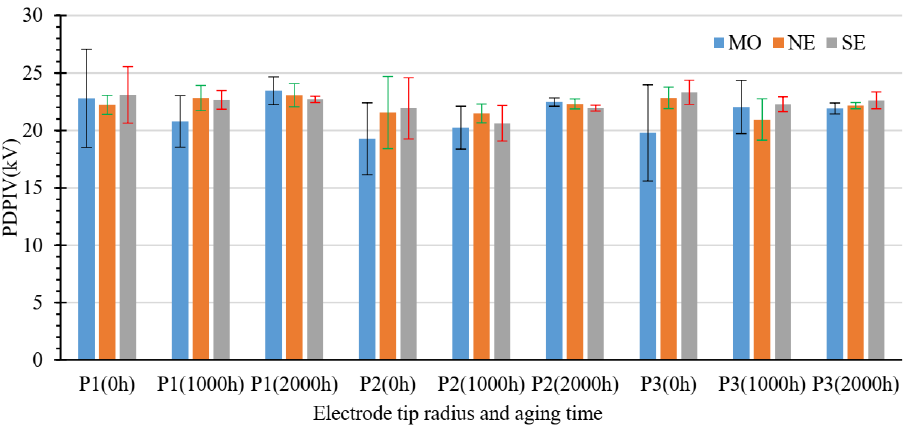
Figure 4. Pre-inception voltage as a function of the electrode tip and aging